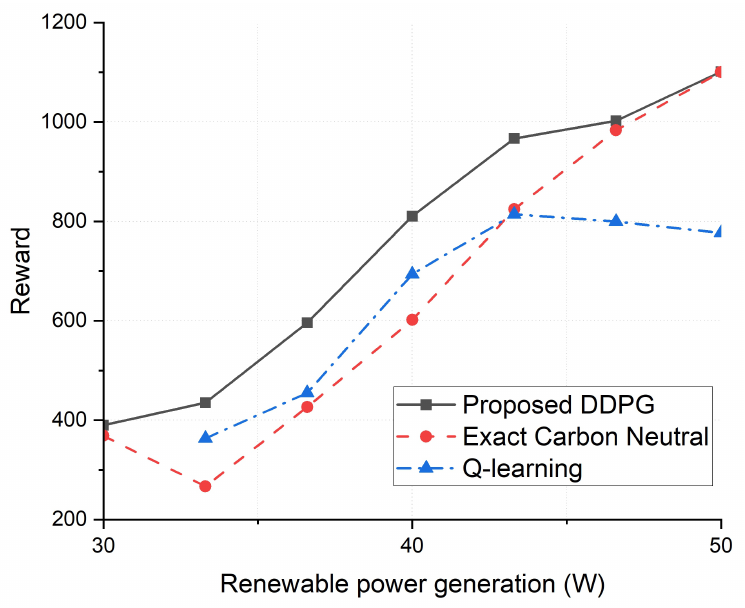
Figure 5. Reward values after training of the DDPG